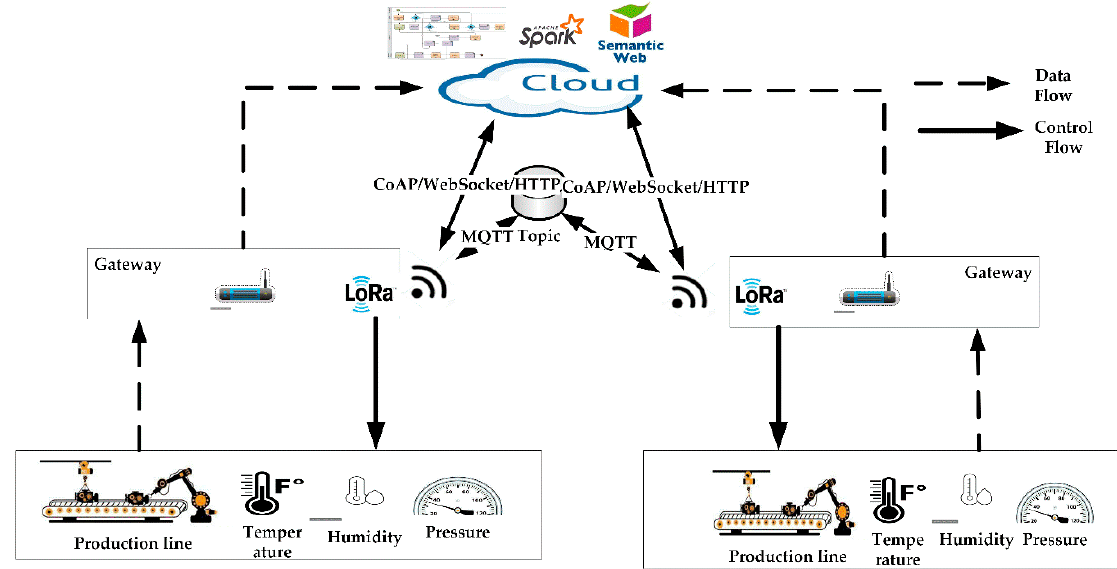
Figure 5. An industrial IoT simulation environment.